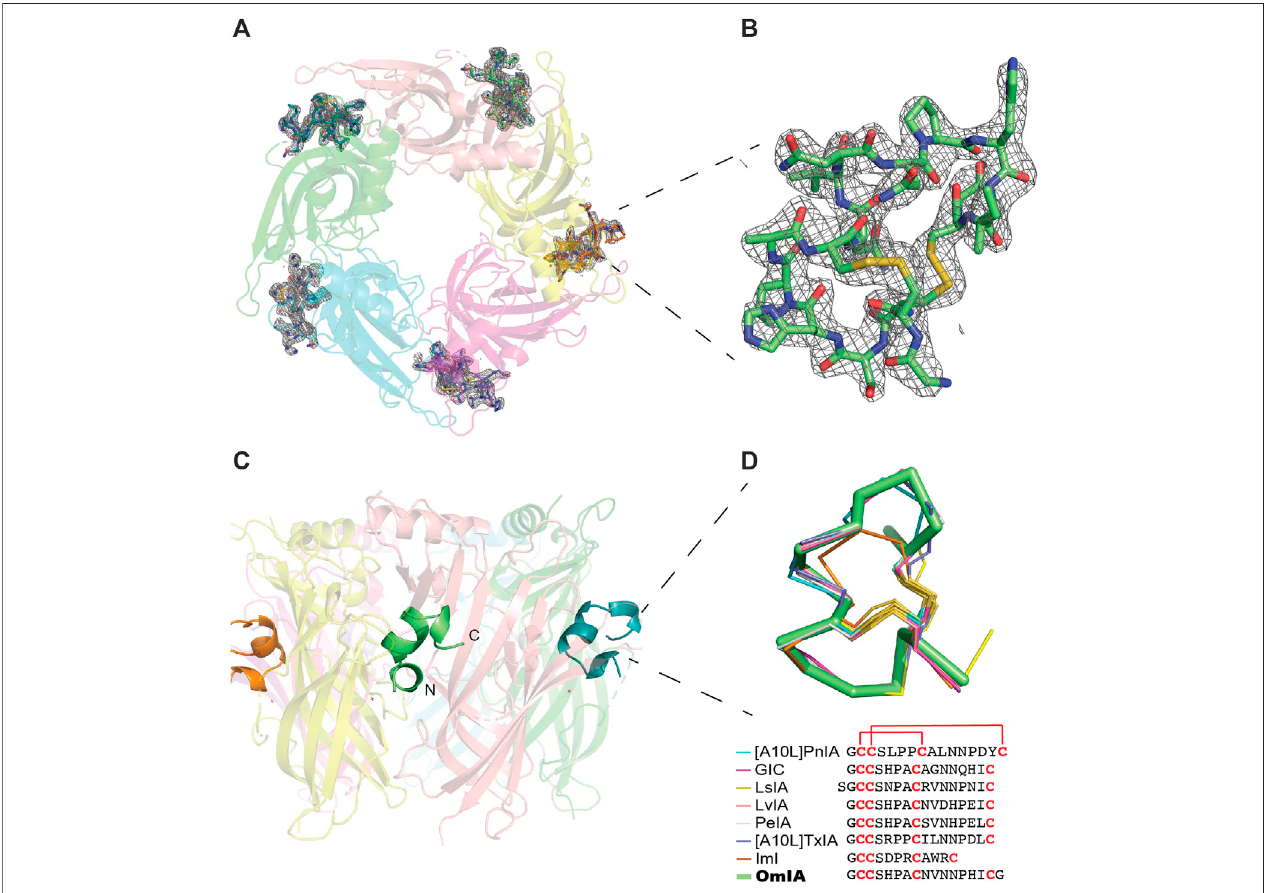
FIGURE1| OmIA/ Ls -AChBPco-crystalstructure. (A) OmIA co-crystalstructurewith Ls -AChBP showsOmIA similarlyresiding ineach ofthe fi ve binding pockets. (B) OmIAthe Fo-Fc map forthe ligand contoured to1.0 σ isalso shown. (C) Thetypical binding mode of α -conotoxinsispresentedby OmIAin which its Nand Ctermini orientate towards the top and bottom of the ligand binding pocket, respectively, while the central helix enters more deeply into the ligand binding pocket. (D) Superimposition of OmIA with previously co-crystallised α -conotoxins shows all bind with a similar backbone orientation [[A10L]PnIA PDB 2BR7, GIC PDB 5CO5, LsIA PDB 5T90, LvIA PDB 5XGL, PeIA PDB 5JME, [A10L]TxIA PDB 2UZ6, ImI PDB 2C9T].